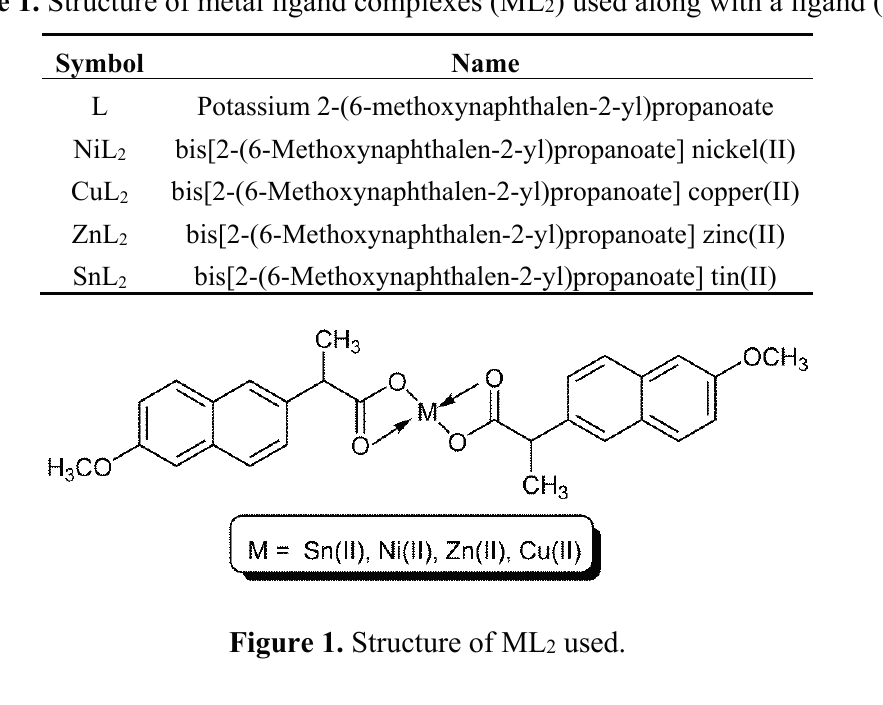
Table 1. Structure of metal ligand complexes (ML 2 ) used along with a ligand (L).